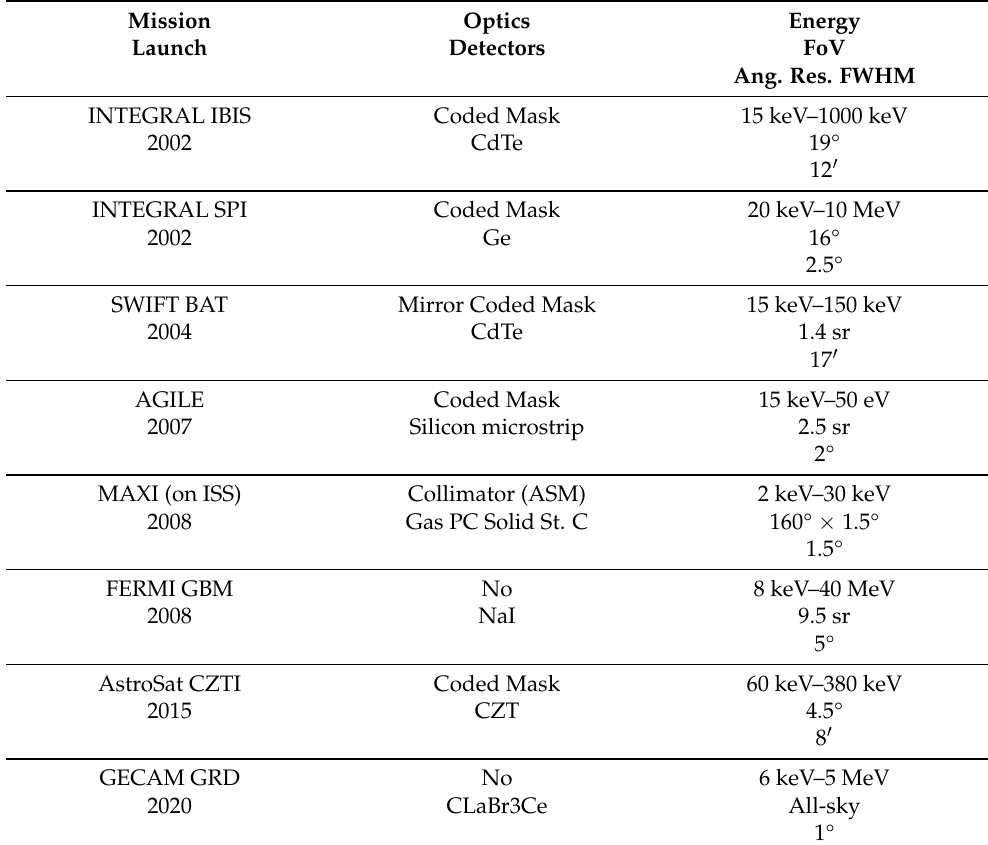
Table 1. Summary of currently active X-ray survey satellite instruments and missions. It includes all mission types: not only followers, but also